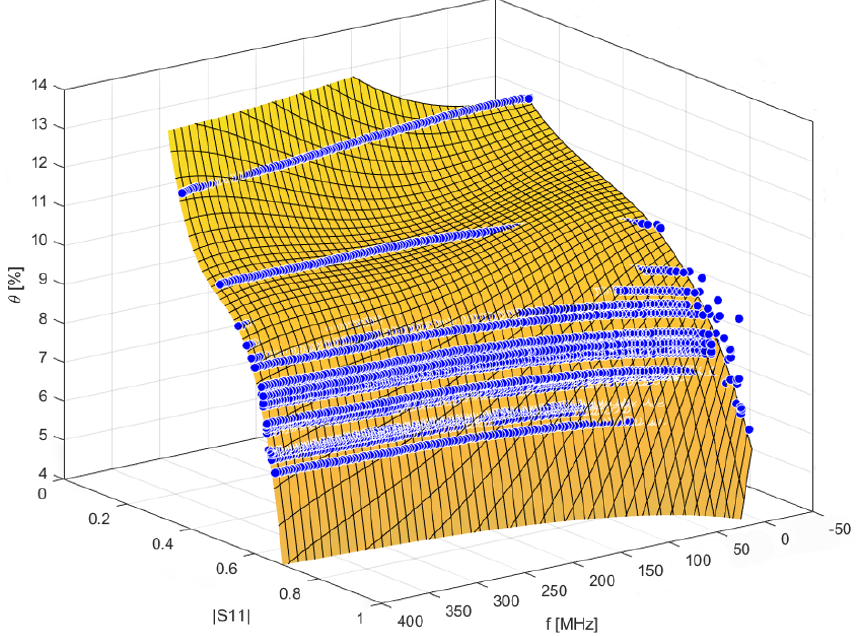
Figure 7. Graphical representation of the calibration